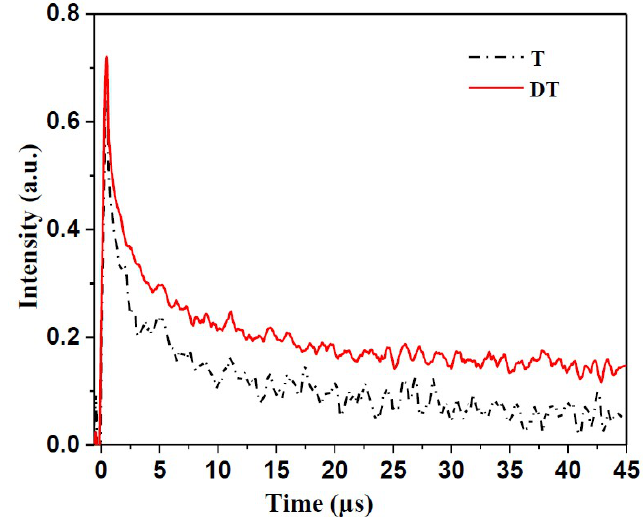
Figure 5. Absorption time profile of T and DT samples at 600 nm.